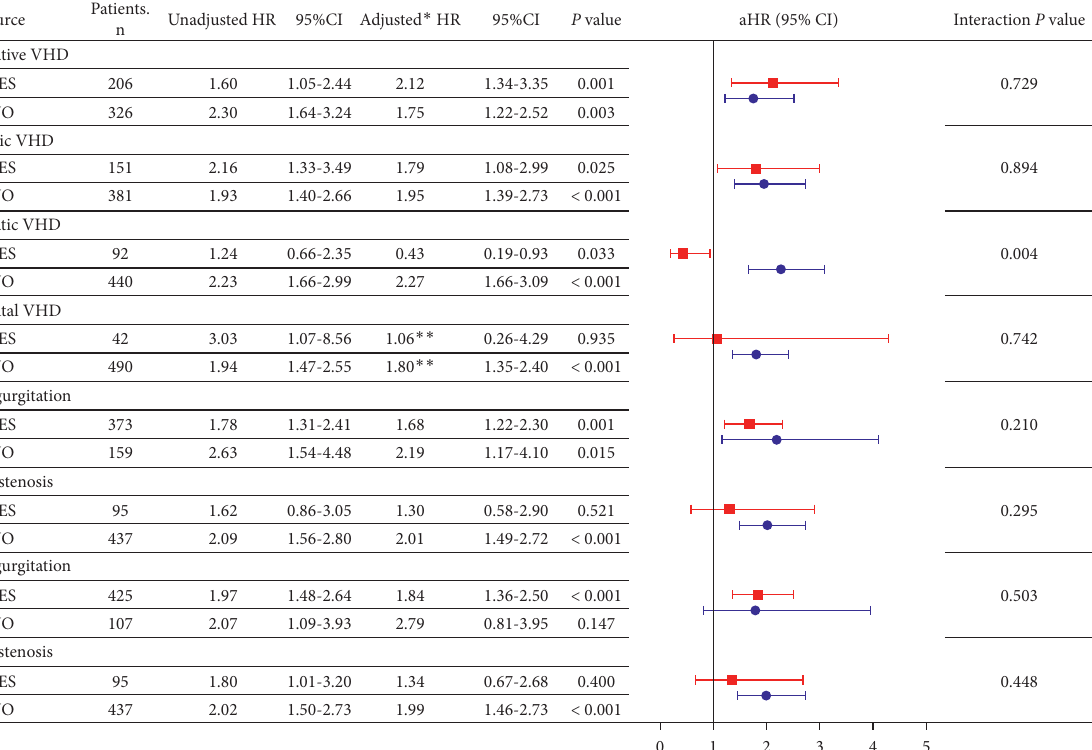
Figure 2: Primary outcome in subgroups of elderly VHD patients. VHD, valvular heart disease; HR, hazard ratio; CI, confidence interval. ∗ Adjusted for age, chronic obstructive pulmonary disease, chronic kidney disease, hypertension, atrial fibrillation, New York Heart Association class, left atrial diameter, aortic regurgitation, beta-blocker, and diuretic. ∗∗ Adjusted for age, chronic obstructive pulmonary disease, chronic kidney disease, hypertension, atrial fibrillation, New York Heart Association class, left atrial diameter, aortic regurgitation, and